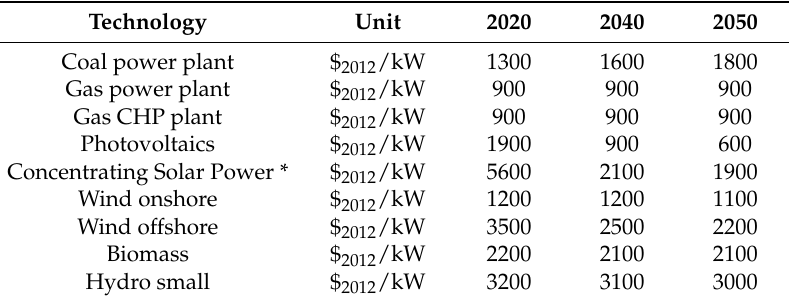
Table 4. Investment cost projections for Brazil and Mexico.